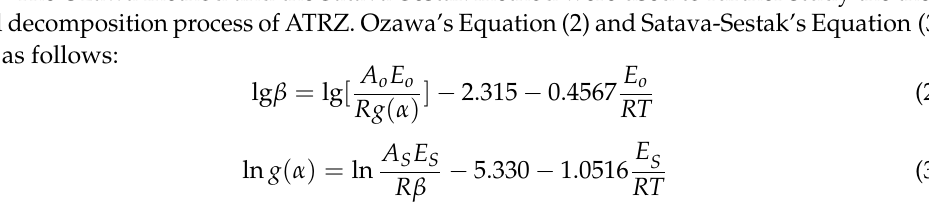
Figure 7. The E k curves of pyrolysis vs. degree of reaction determined by the Kissinger method.